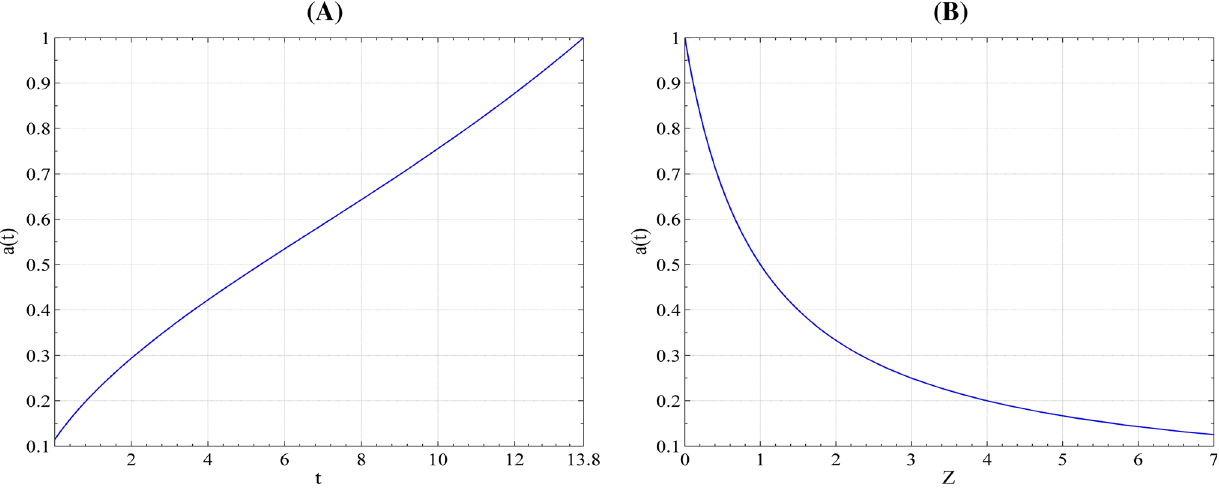
Fig. 1 Plot a indicates the scale factor a ( t ) versus time t at the time range [ 0 . 0006 , 13 . 816 ] , while plot b shows the scale factor a ( t ) versus redshift z at the redshift range [ 0 , 7